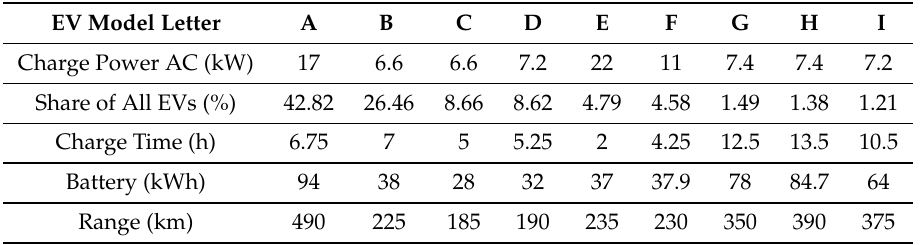
Table 1. Electric vehicle (EV) model mix and corresponding parameters, adopted from Reference